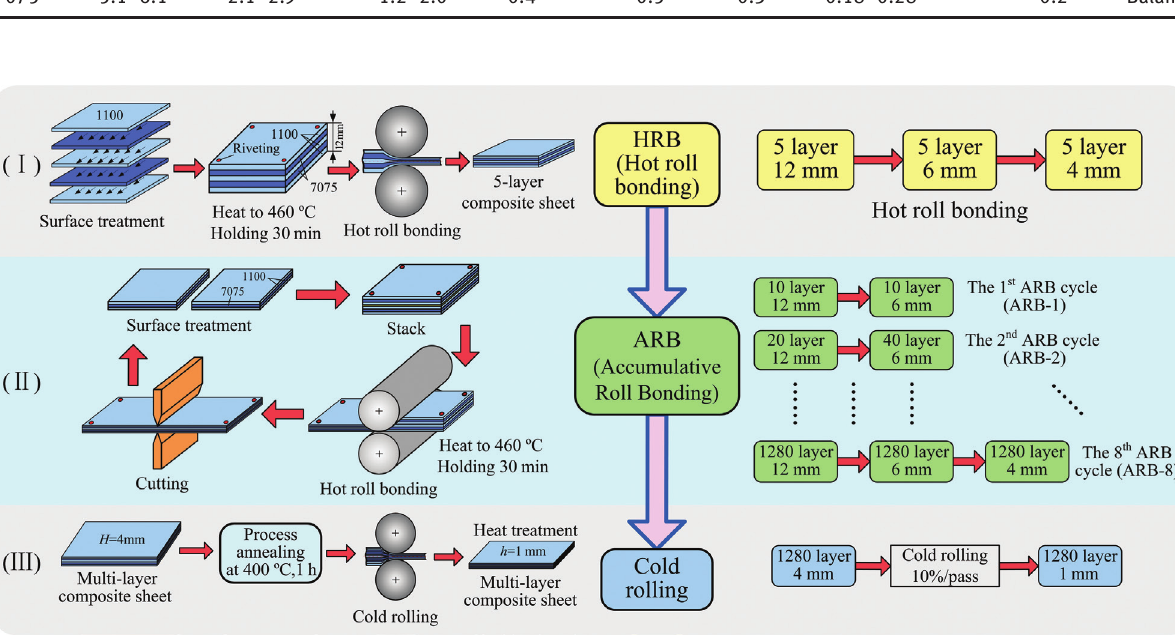
Figure 1 Schematic diagram of cold rolling process and its rolling schedule of LMCS.